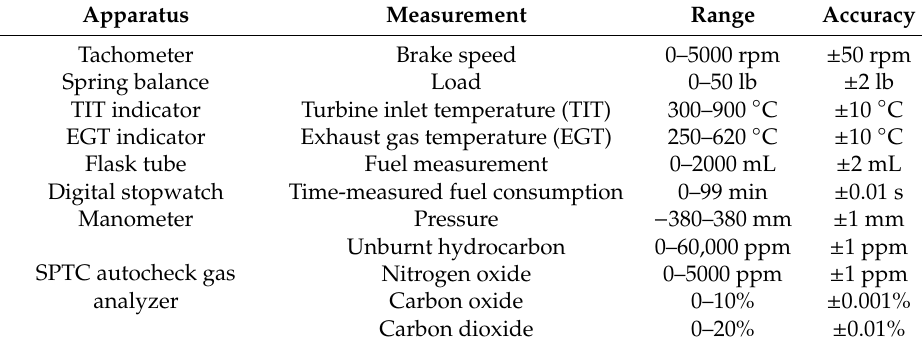
Table 5. Technical data and uncertainty of experiment apparatuses. Adapted from